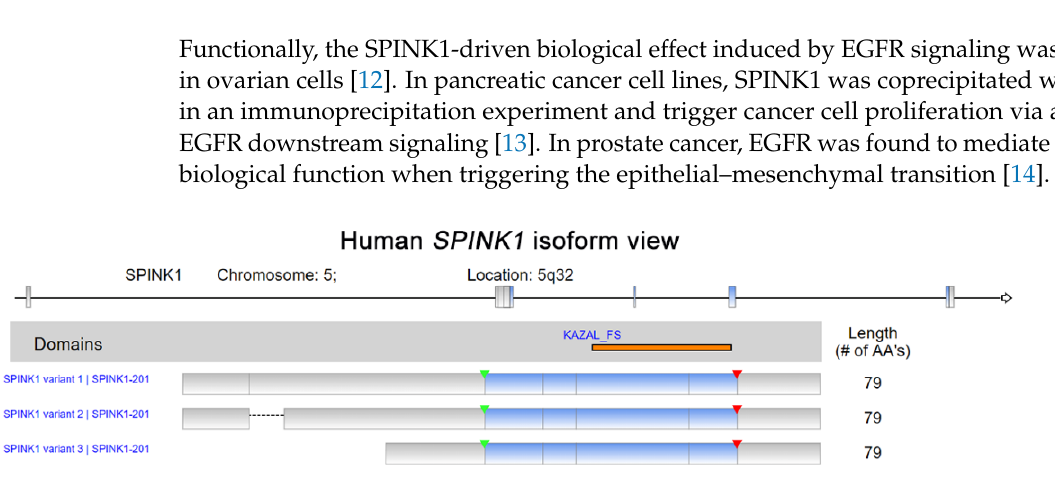
Figure 1. Human Serine peptidase inhibitor Kazal type I ( SPINK1 ) isoform view. The data were retrieved and analyzed from Refseq. The matching protein domains in various RNA isoforms are marked and located in orange. The start of transcription and position of a stop codon are indicated by green and red arrowheads, respectively.